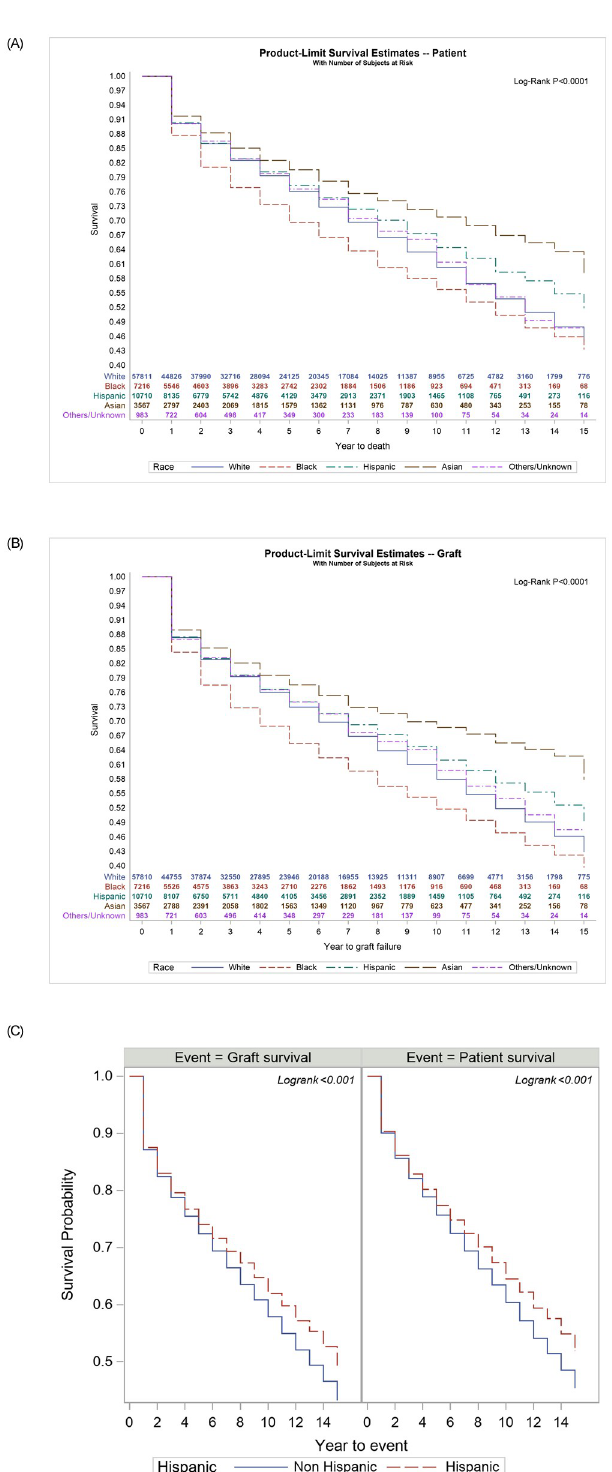
Fig 2. A. Post liver transplantation Kaplan Meier patient survival stratified by races (number at risk at different time points shown in inner panel); B. Post liver transplantation Kaplan Meier graft survival stratified by races (number at risk at different time points shown in inner panel); C. Post liver transplantation Kaplan Meier patient and graft survival in Hispanics when compared to others.